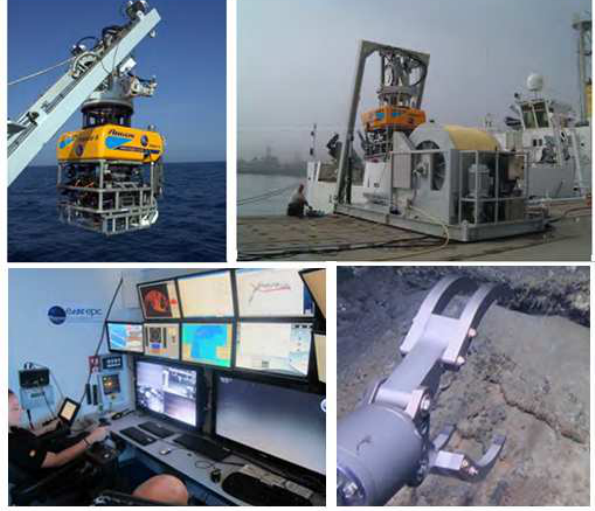
Figure 9. Picture of Argus ROV